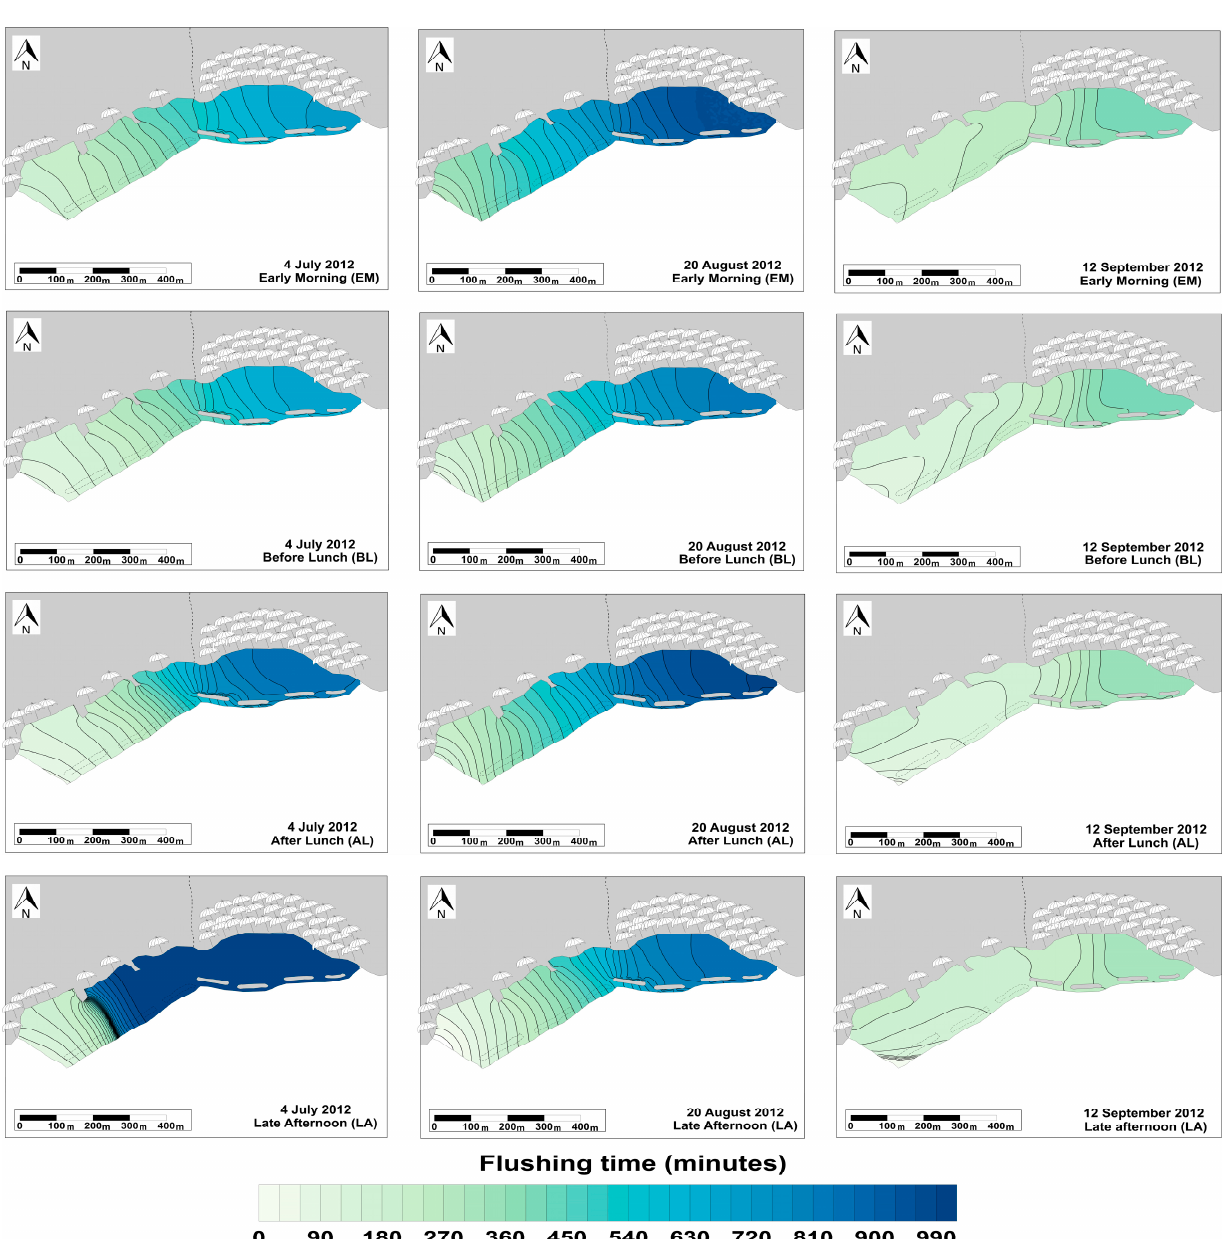
Figure 6. Flushing Time calculated on the VBNC E. coli (FT-VBNC) within La Perla del Tirreno bathing area. FT-VBNC is represented in the three sampling days of summer 2012 (July, August, September, in columns) and in the four daily periods (in rows).